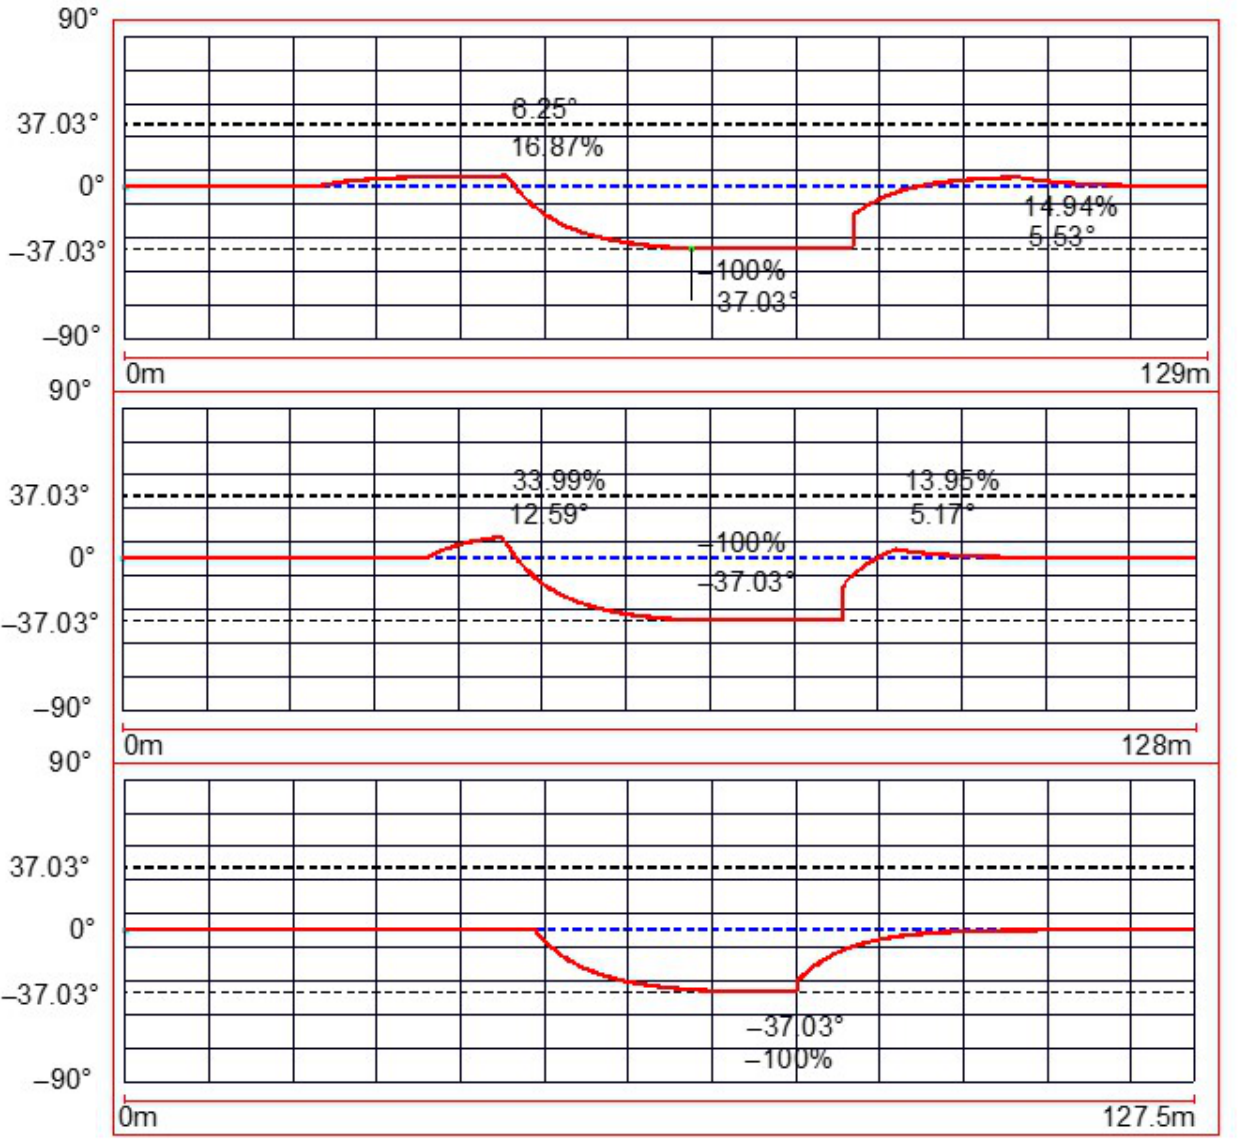
Figure 7. Italian bus steering diagrams (D = 7, 13 and 19